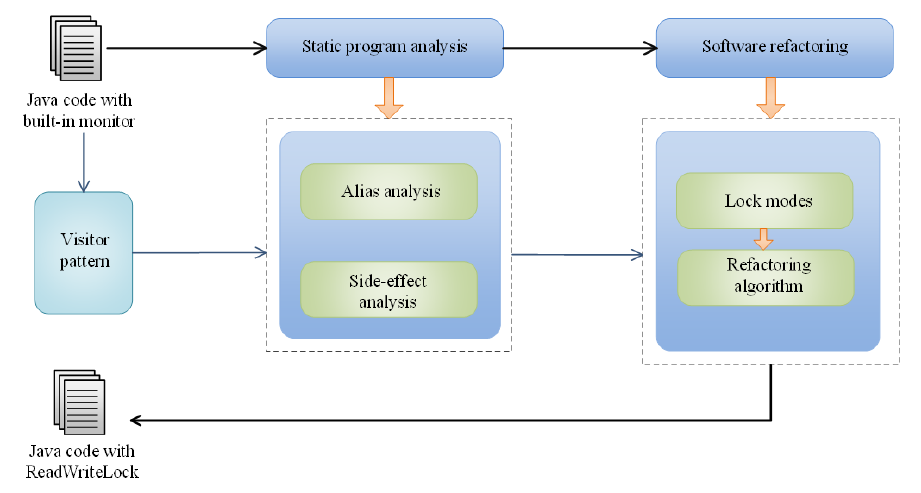
Figure 3. The refactoring